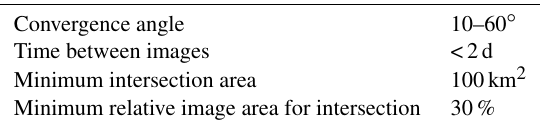
Table 1. Cross-track stereo pair